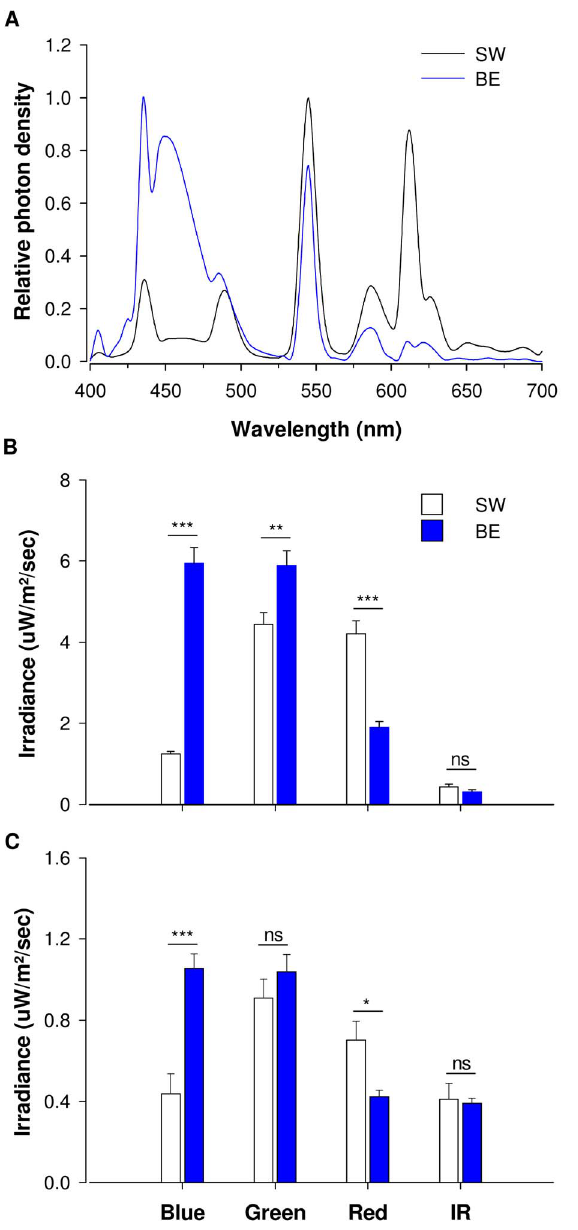
Figure 1. Characteristics of the lighting environments. A . Spectra of ambient lightings used in the study. In a black straight line the spectrum of the control SW light used in weeks 1, 4, 5, 8 and 9 of the study. In a blue straight line the spectrum of the BE light used in weeks 2, 3, 6, and 7 of the study. B . Intensity (irradiance) and spectral composition of the lighting environments as measured in different locations of the Polar Station. BE light contained significantly more energy in the blue (p , 0.001) and green (p , 0.01) range of the light spectrum, and less red (p , 0.001) compared to SW light. C . Intensity (irradiance) and spectral composition of the lighting environments as measured by the Lightwatcher device worn by the participants. The light spectra measured by the polar station workers under BE light contained significantly more short wavelength blue light (p , 0.001) and less long wavelength red light (p , 0.05) compared to SW light. Intensity of middle wavelength green light and IR light detected by the participants were not significantly different. See Table S1 and Figures S2 and S3 for more details.